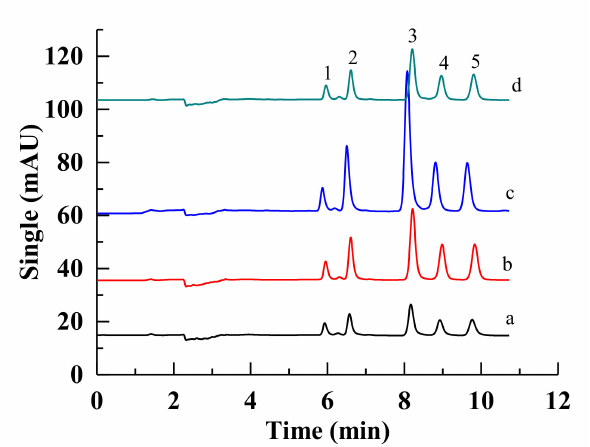
Figure 9. Chromatograms of the target compounds using four kinds of fibers (a, b, c, d) with different surface wettability. The concentration of each compound of PAHs is 10 µ g/L. Peak iden- tification: 1. naphthalene, 2. acenaphthylene, 3. acenaphthene, 4. phenanthrene, 5. Anthracene. Water/acetonitrile (25:75, v/v ), Detection wavelength, 226 nm. Other conditions are the same as Figure